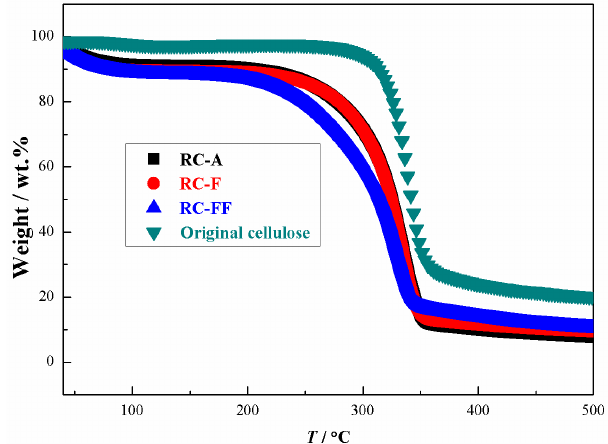
Figure 5. Thermal decomposition profiles of RC-A, RC-F, and RC-FF, and the original cellulose.